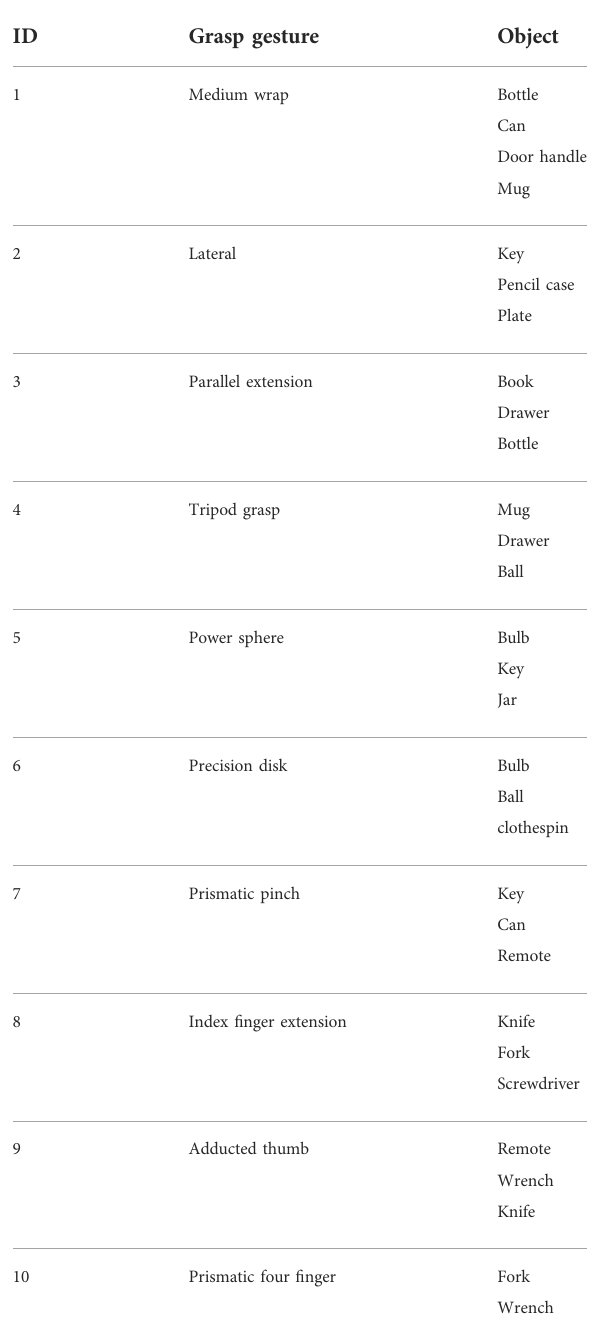
TABLE 1 Columns indicate the ID, the name of the grasp gestures, and the name of the object involved in the grasping (Cognolato et